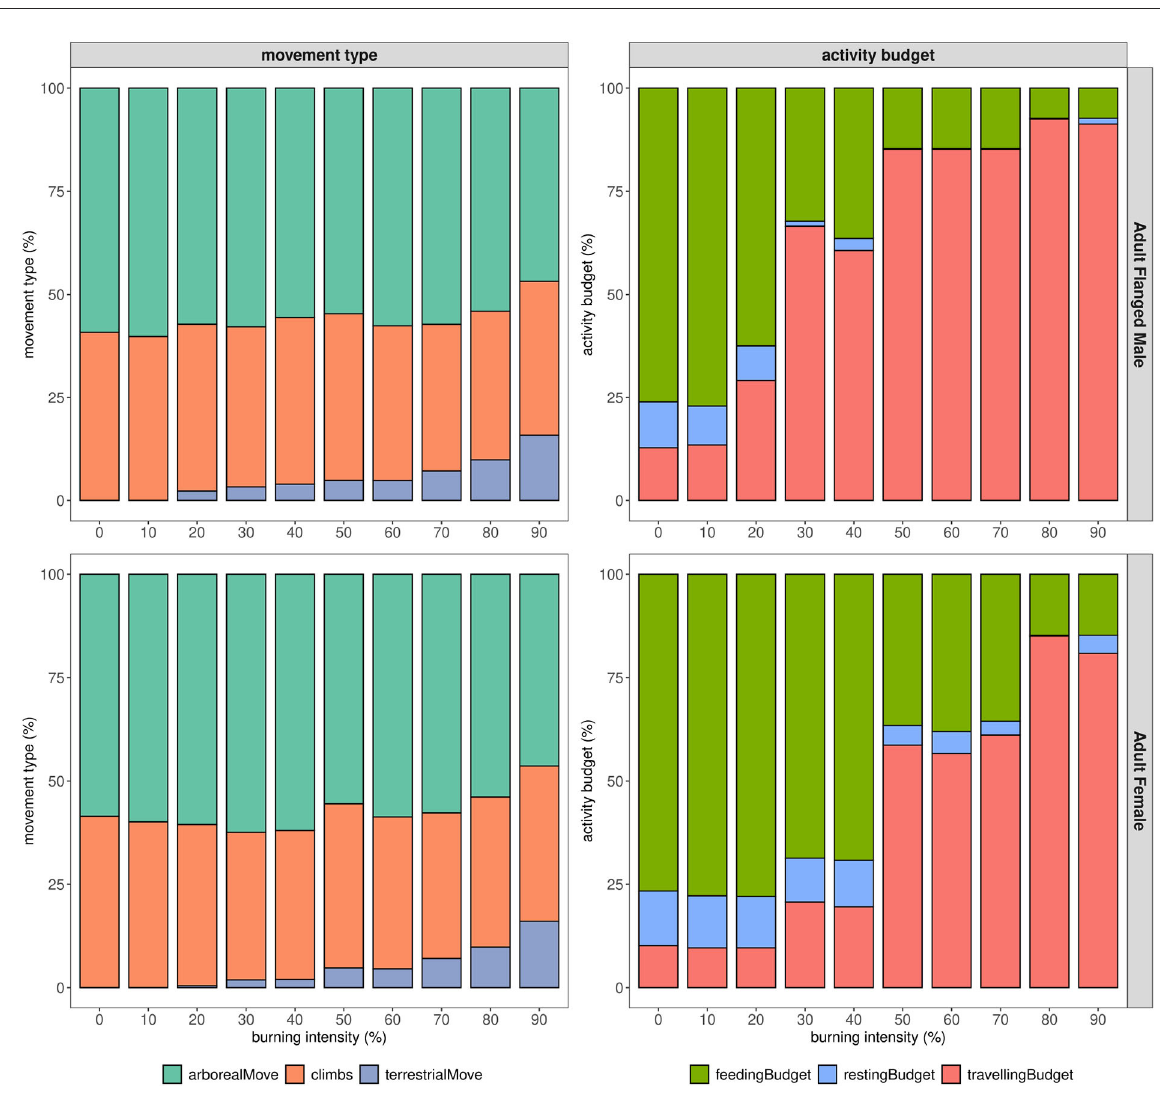
FIGURE7 Scenario test with the calibrated model for adult flanged male and adult female visualized in proportional-bar-charts. Each bar is divided into three categories as in the legend, either showing the three different types of move, or the different activity budgets. The model is initialized with the parameter set referring to Table 3. The number of trees and fruiting trees refers to Supplementary Table